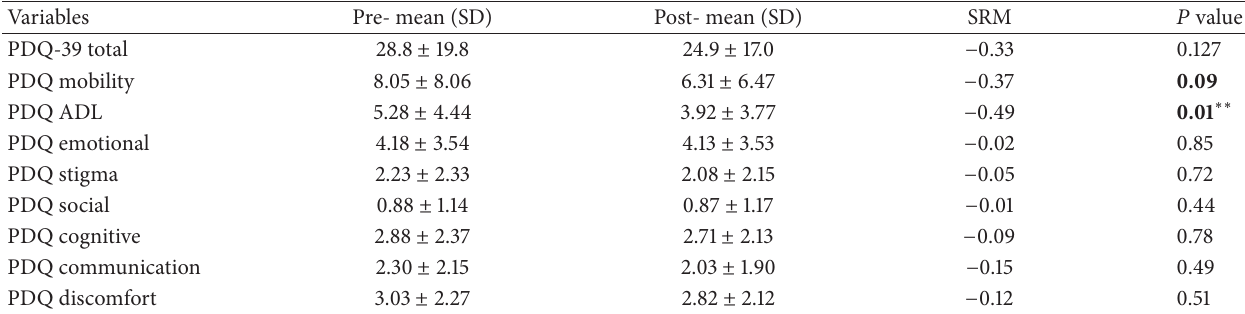
Table 4: Effects of exercise on the PDQ-39